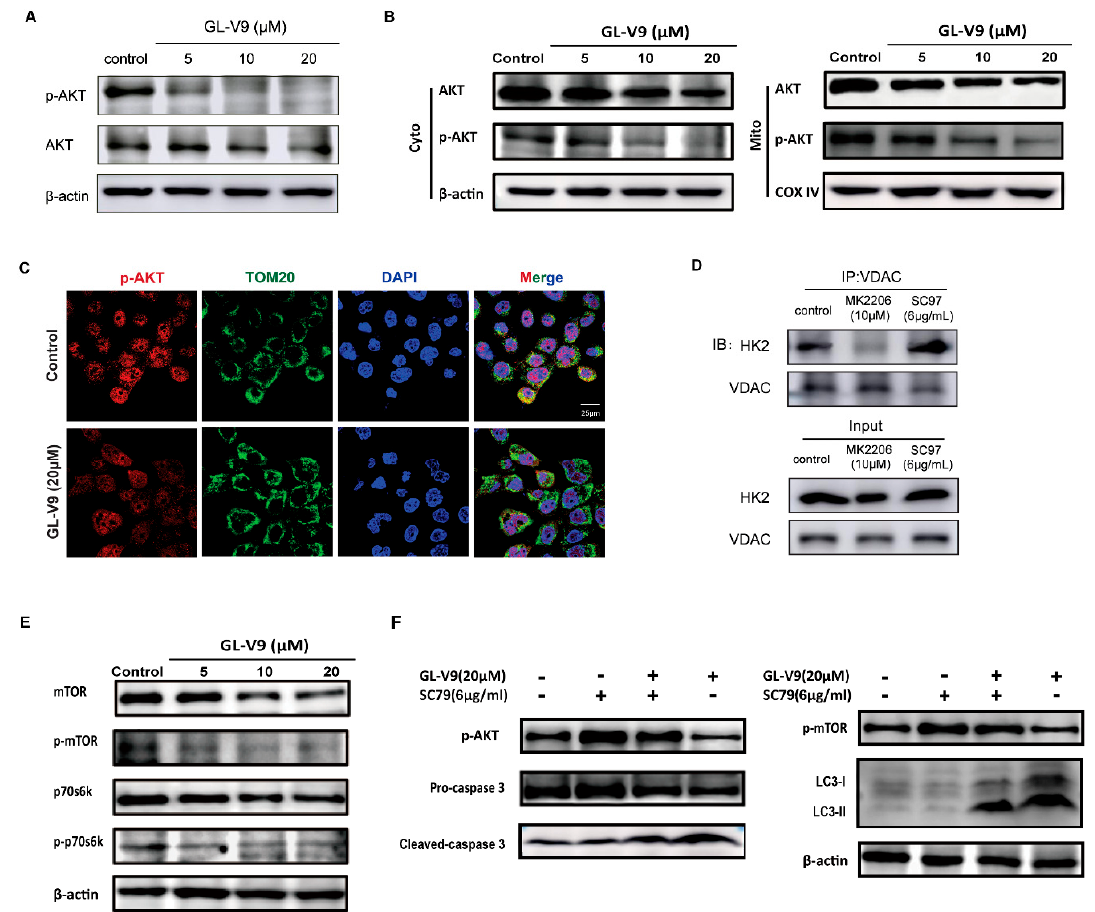
Figure 6. Inhibition of AKT by GL-V9 is responsibility for the decreasing binding of HK2 in mitochondria and induction of autophagy. ( A ) A431 cells were treated with GL-V9 for 36 h. The protein expression of AKT and p-AKT were assayed. ( B ) The expression of AKT and p-AKT proteins in cytosol and mitochondria was examined by western blot. ( C ) The location of p-AKT in mitochondria was observed by immunofluorescence. Scale bar = 25 μ m . ( D ) A431 cells were treated with 10 μ M MK2206 or 6 μ g/mL SC97 for 36 h, respectively. The binding of HK2 with VDAC was assayed by immunoprecipitation. ( E ) Western blot assays were used to examine the protein expression of mTOR, p-mTOR, p70s6k, and p-p70s6k. ( F ) A431 cells were co-treated with SC79 and GL-V9 for 36 h. The expression of key proteins involved with apoptosis and autophagy were assayed.